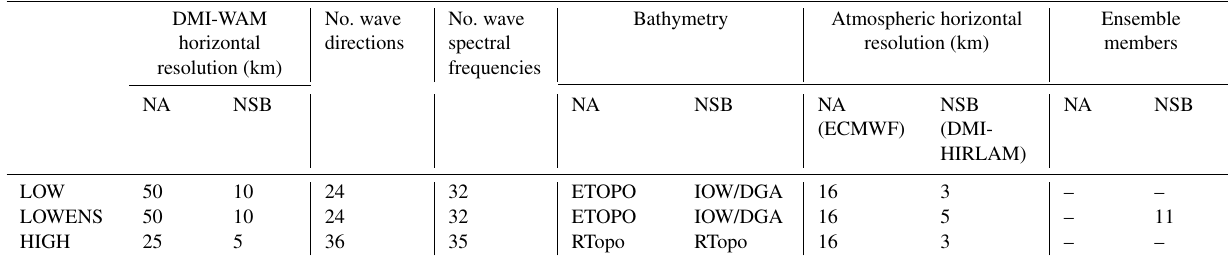
Table 2. Details of DMI-WAM configuration used in this study.